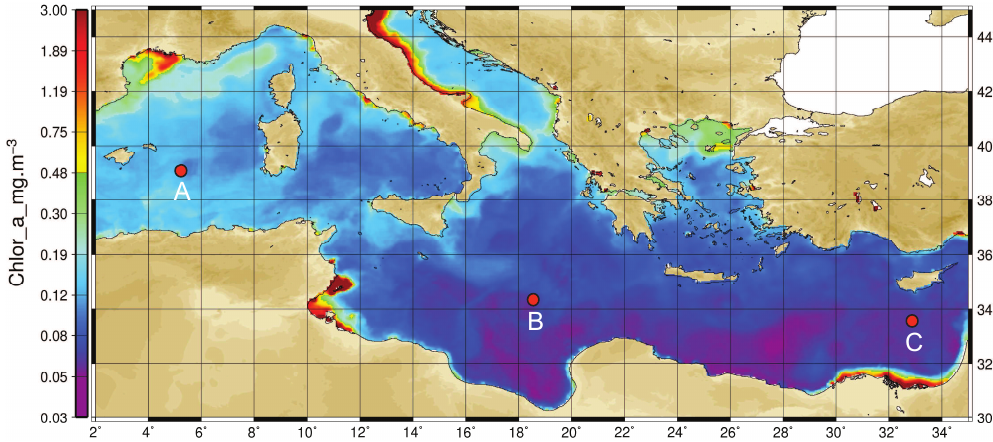
Fig. 1. Location of the stations A, B, and C sampled during the BOUM cruise, superimposed on a SeaWIFS ocean color composite indicating values of total chlorophyll- a (15 June–15 July